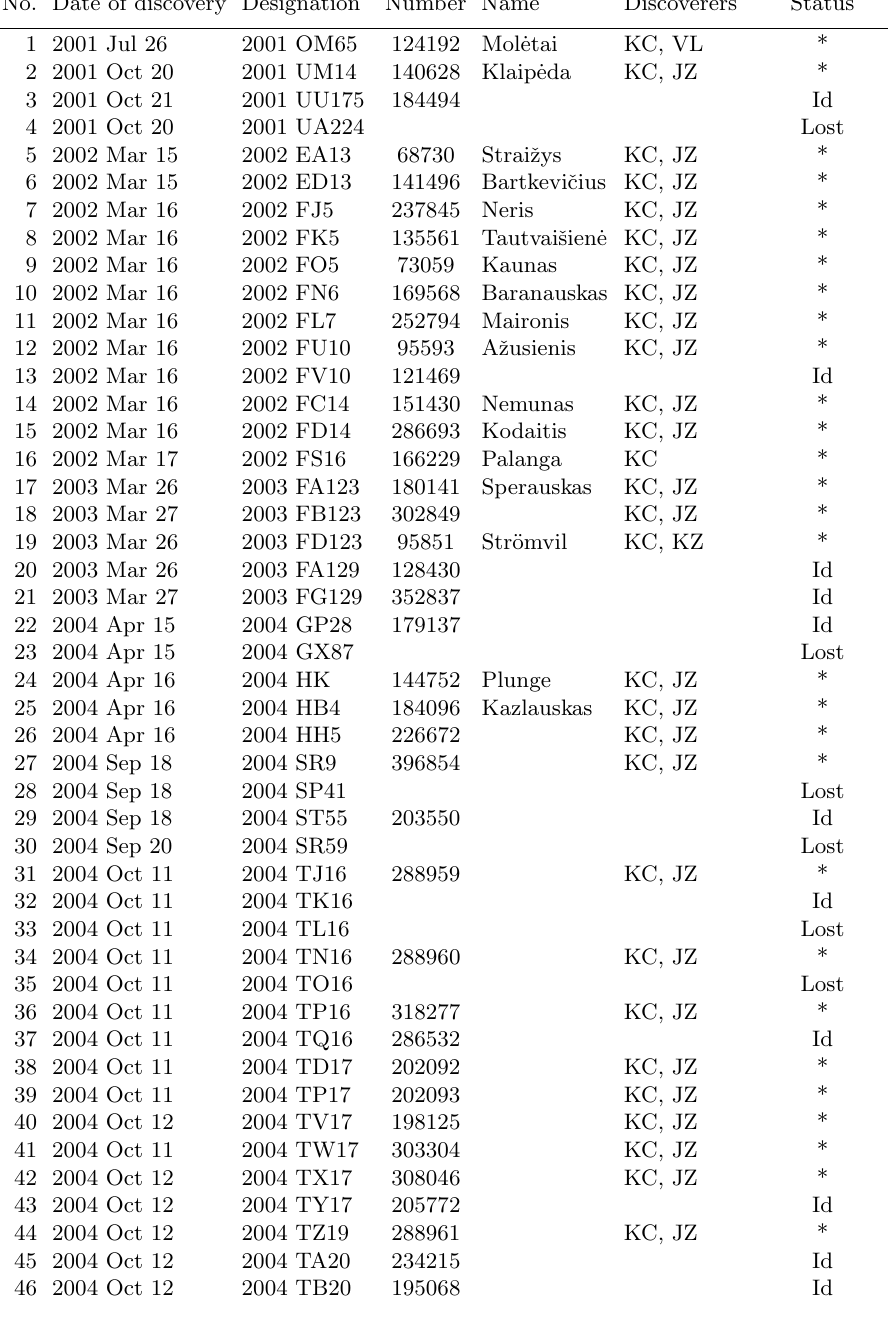
Table 2. List of asteroids discovered at the Mol˙etai Observatory in